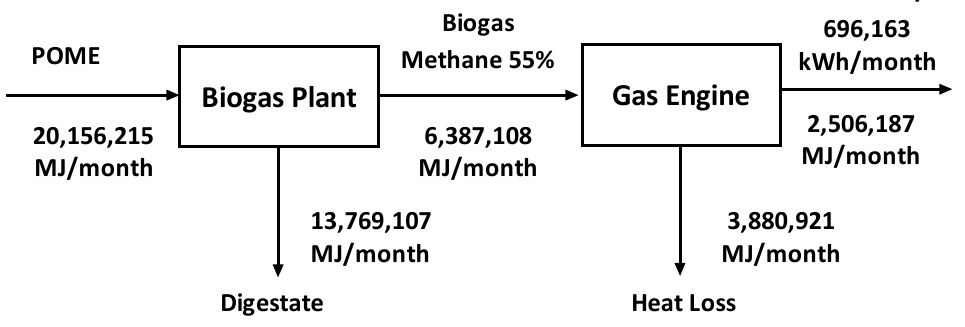
Figure 5. Energy conversion in the system.